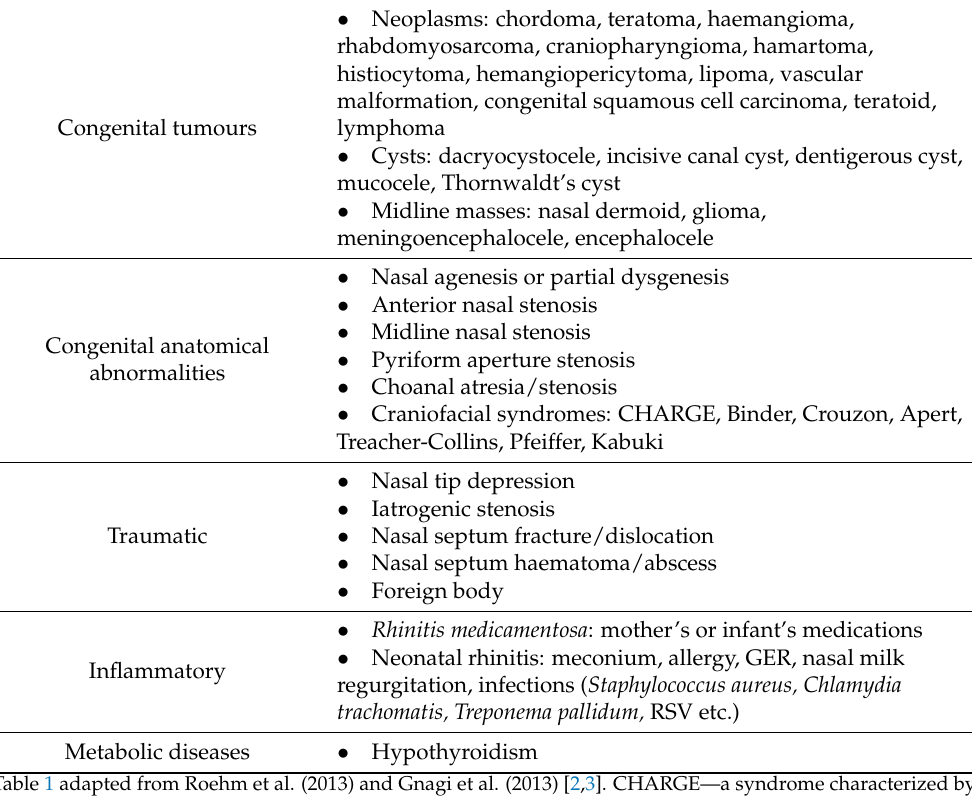
Table 1 adapted from Roehm et al. (2013) and Gnagi et al. (2013) [2,3]. CHARGE—a syndrome characterized by coloboma (C), congenital heart defect (H), choanal atresia (A), mental and growth retardation (R), genitourinary tract (G) and ear abnormalities (E); GER—gastroesophageal reflux; RSV–respiratory syncytial